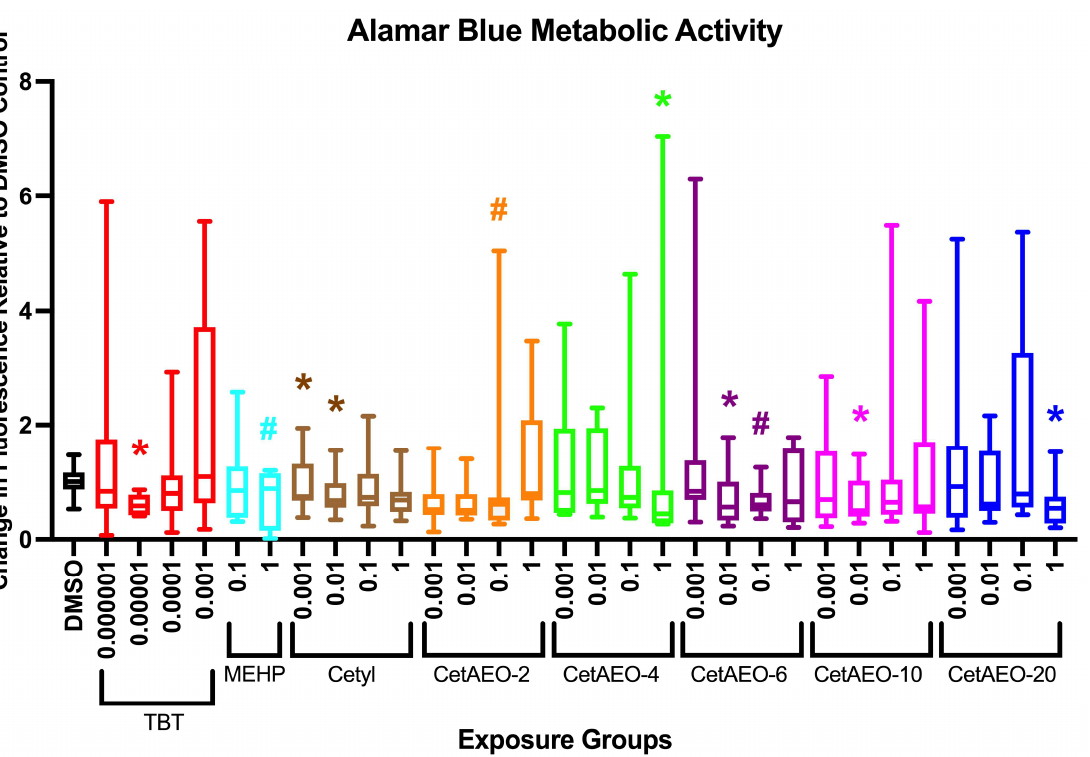
Figure 3. Metabolic Activity in Zebrafish Developmentally Exposed to Cetyl Alcohol and Polyethoxylates. Zebrafish were developmentally exposed to control chemicals, cetyl alcohol, or cetyl alcohol polyethoxylates. Immediately following exposure, at six days post fertilization, metabolic activity was measured using the alamar blue assay. Four groups of three replicate fish were transferred into wells of a 24 − well black clear − bottom plate, media removed, and alamar blue solution added to wells. Plates were immediately read for fluorescence, then incubated in the dark overnight before measuring fluorescence again. The increase in fluorescence is correlated with increased metabolic activity in the fish. Chemical − exposure − treated fish responses were compared with DMSO (0.1%, vehicle control) − treated fish to determine significant differences. N = 9 replicate fish in each biological replicate (spawning event), and three spawns were performed for approximately 27 fish per exposure group. * indicates significant change in arbitrary fluorescence compared to vehicle control fish, p < 0.05, as per Kruskal–Wallis test with Dunn’s multiple comparisons. # represents 0.05 < p < 0.10. DMSO = dimethylsulfoxide, vehicle control; TBT = tributyltin chloride; MEHP = Mono(2 − ethylhexyl) phthalate; CetAEO = cetyl alcohol polyethoxylates (with varying average ethoxylate chain lengths). Box and whisker plots depict the following metrics: whiskers represent 10–90th percentiles, box bounds represent the 25th to 75th percentiles, and the middle line represents the median. All concentrations are provided in µ